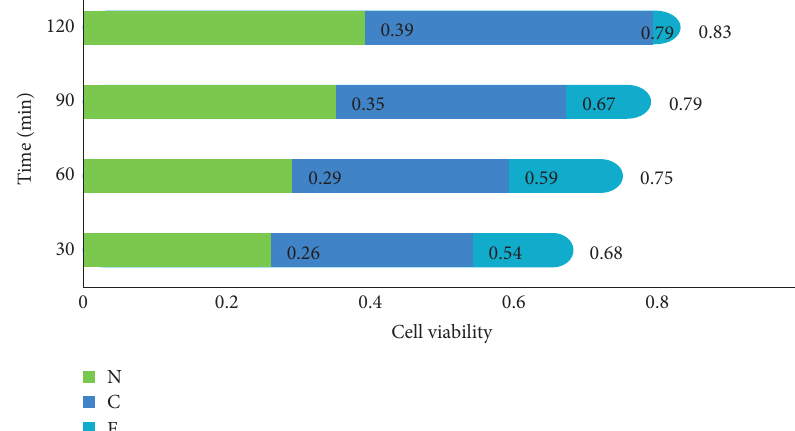
Figure 3: Stem cell proliferation activity detection.